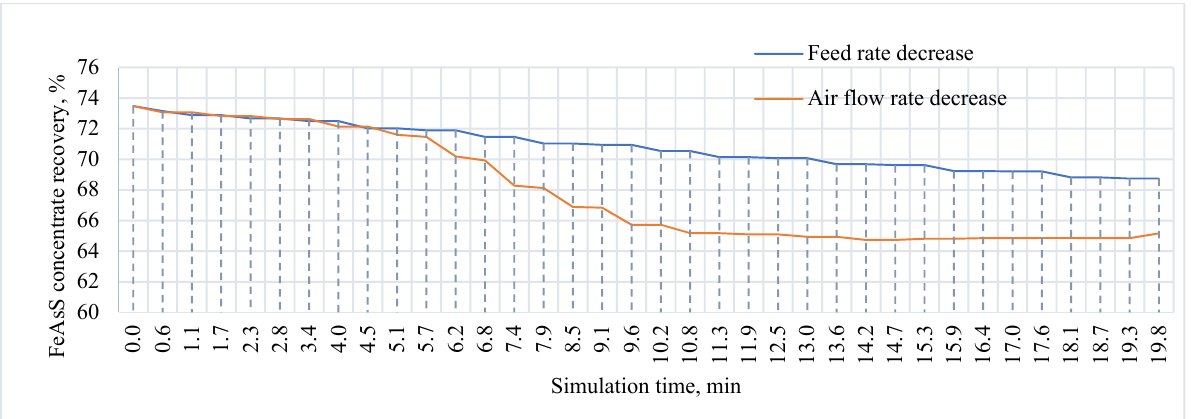
Figure 14. FeS 2 concentrate grade values in the simulation.